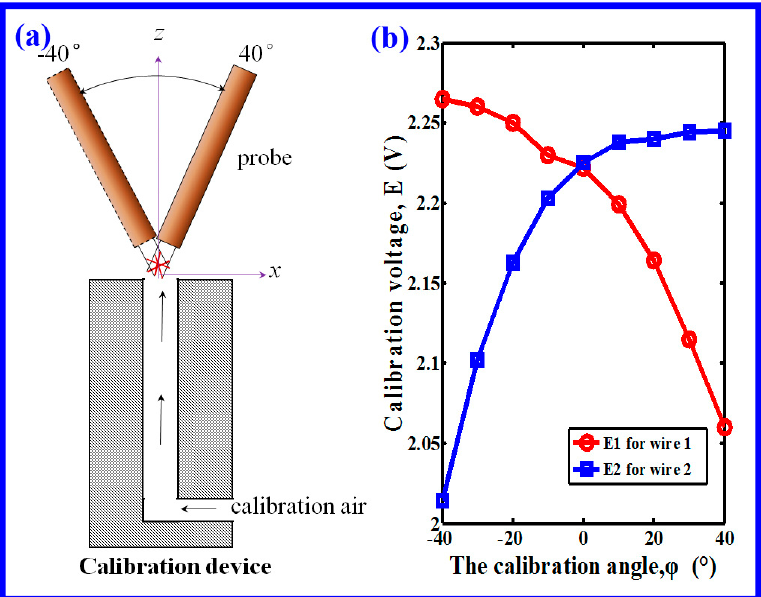
Figure 5. ( a ) Schematic of devices for the directional calibration of the CTA. Directional calibration was performed by exposing the probe (wires) to a known air velocity from different angles. ( b ) Calibration angle and its two corresponding voltages for the dual wires.